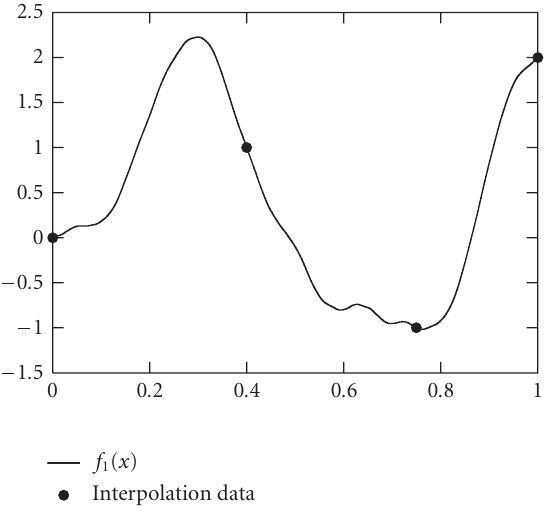
Figure 5.3. E ff ect on spline CHFIF by a change in the hidden variables α n .